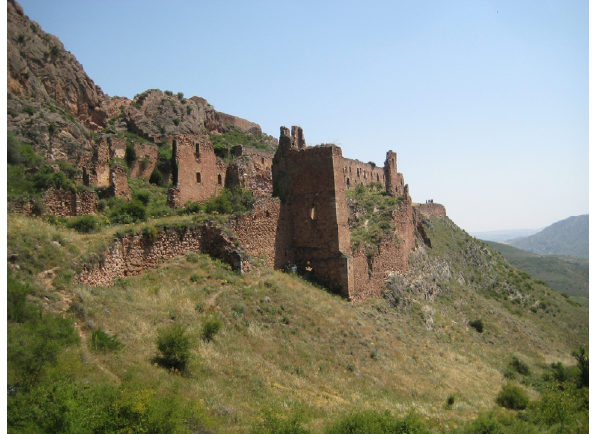
Figure 4. Ruins of San Prudencio’s